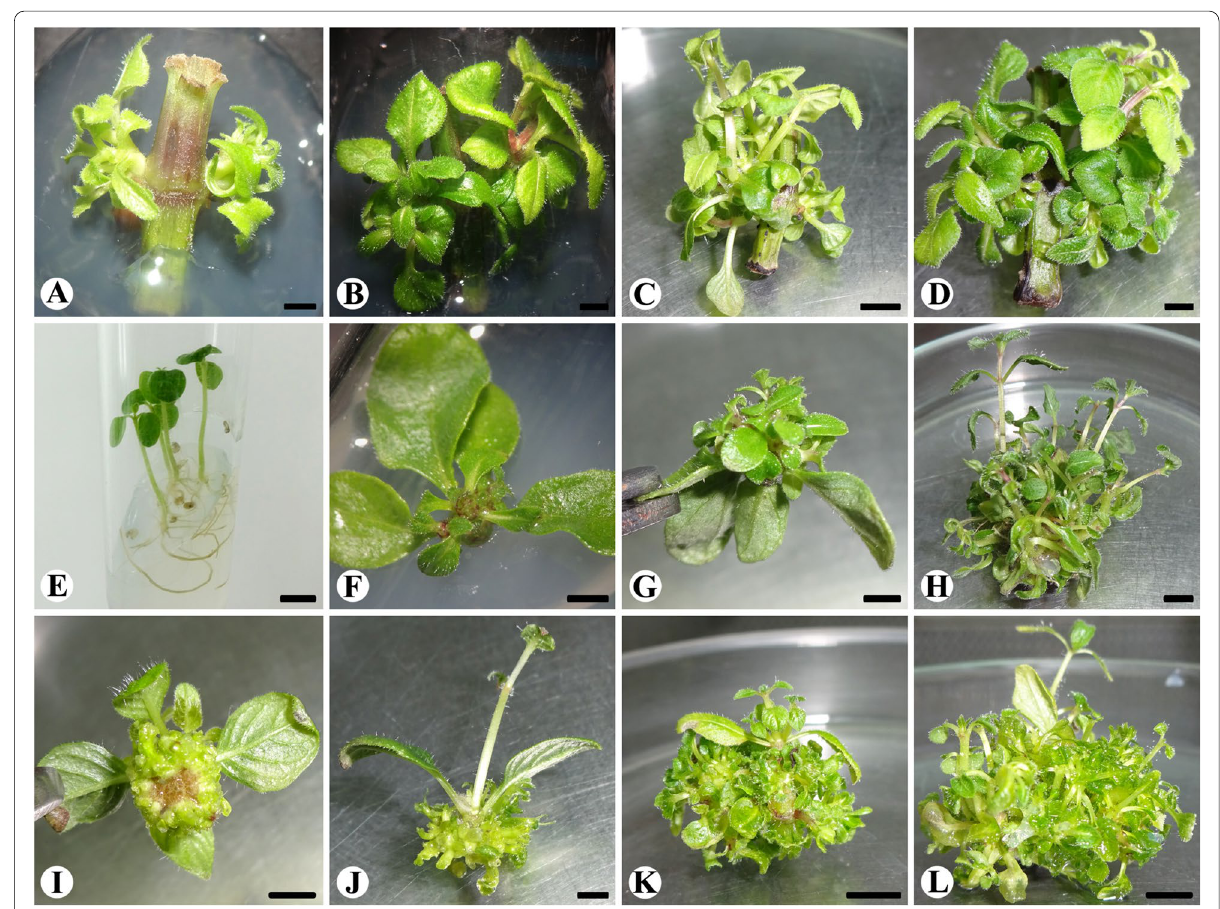
Fig. 1 In vitro shoot regeneration from nodal and shoot tip explants of Andrographis producta on Murashige and Skoog medium supplemented with cytokinins. A Induction of axillary shoots from the nodal explant on MS medium supplemented with 10 μM 2-iP after 2 weeks of culture (bar-, 0.20 cm). B Shoot multiplication from nodal explant on MS medium supplemented with 10 μM 2-iP after 4 weeks (bar-, 0.23 cm). C Shoot proliferation from nodal explant on MS medium containing 10 μM 2-iP after 6 weeks (bar-, 0.35 cm). D Multiple shoots regeneration from nodal explant after 8 weeks of culture on medium supplemented with 10 μM 2-iP (bar-, 0.30 cm). E In vitro seed germination on 1/10th strength MS basal medium (bar-, 0.7 cm). F Initiation of multiple shoots from shoot tip explant on MS medium supplemented with 5 μM BAP after 2 weeks (bar-, 0.75 cm). G Proliferation of shoots from shoot tip explant on medium supplemented with 5 μM BAP after 4 weeks (bar-, 0.9 cm). H Multiple shoots regeneration from shoot tip explant after 8 weeks of culture on MS medium supplemented with 5 μM BAP (bar-, 0.98 cm). I Initiation of direct shoot buds from cut end region (basal region) of shoot tip explant after 2 weeks of culture on MS medium containing 10 μM 2-iP (bar-, 0.60 cm). J and K Proliferation of shoots from cut end region (basal region) on shoot tip explant on MS medium containing 10 μM 2-iP after 4 and 6 weeks, respectively (bar-, 0.55 cm and 1.15 cm for J and K , respectively). L Multiple shoots regenerated from a cut end region of shoot tip explant after 8 weeks of culture on MS medium supplemented with 10 μM 2-iP (bar, -1.03